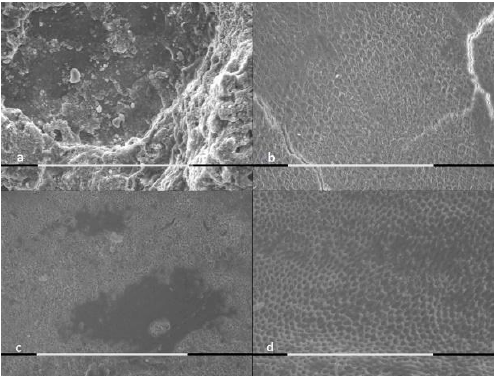
Figure 2. SEM pictures (800×, marker 100 μ m) of enamel exposed to hydrochloric acid for 5 min: ( a ) enamel brushed with AZ ProExpert ® toothpaste; ( b ) untreated controls; ( c ) enamel treated with Colgate Total Original ® toothpaste; and ( d ) untreated controls.